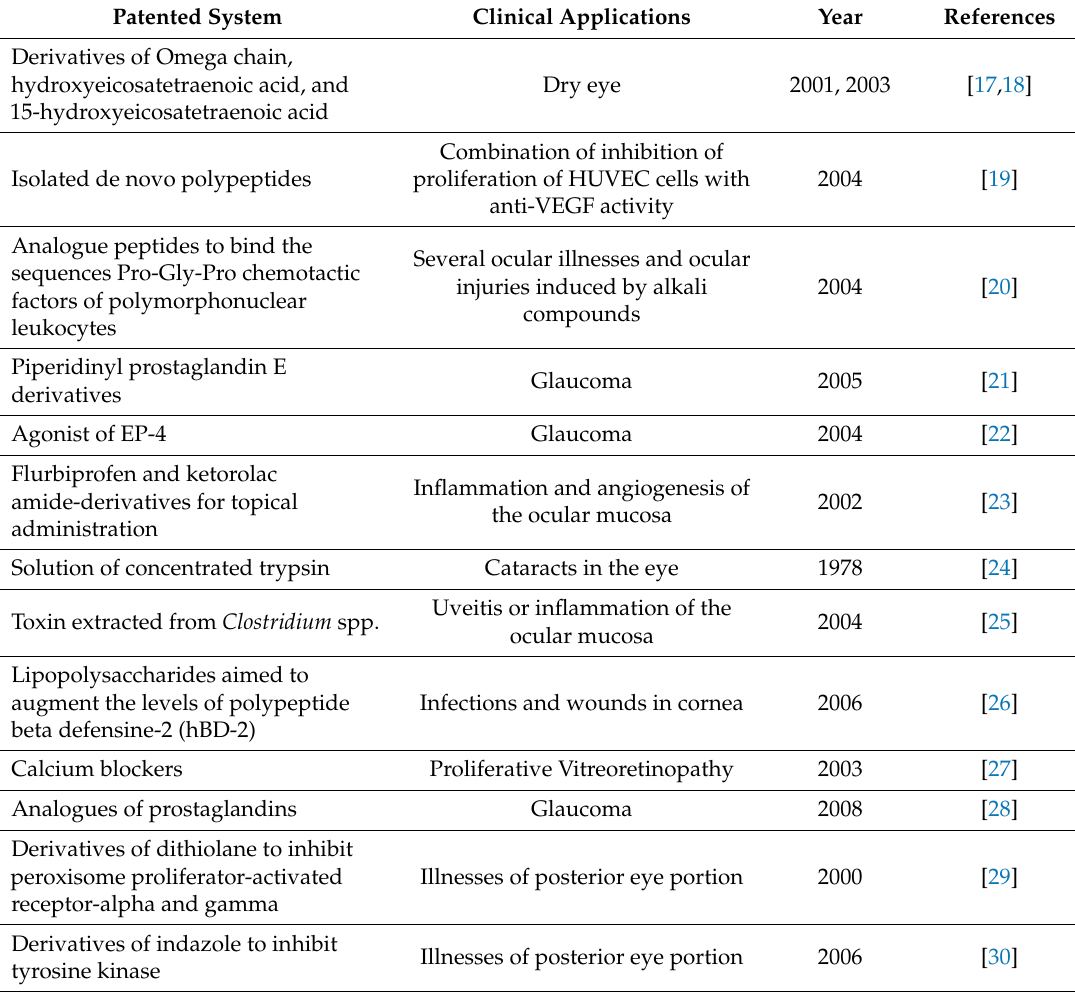
Table 2. Therapeutic molecules, biological targets and potential clinical